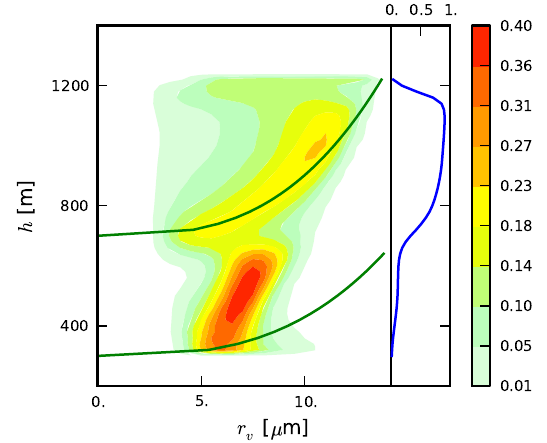
Fig. 13. CFAD of the parameter α . Only cloudy points where the subgrid-scale mixing takes place are included. Red line shows the average profile. The frequency of mixing events (i.e., the number of points undergoing turbulent mixing divided by total number of points at each level) is shown on the right-hand side with the blue